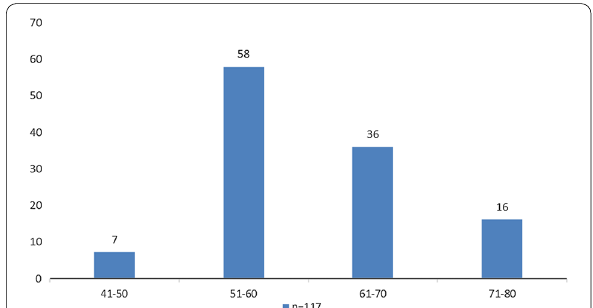
Fig. 1 Age distribution of patients with BPE